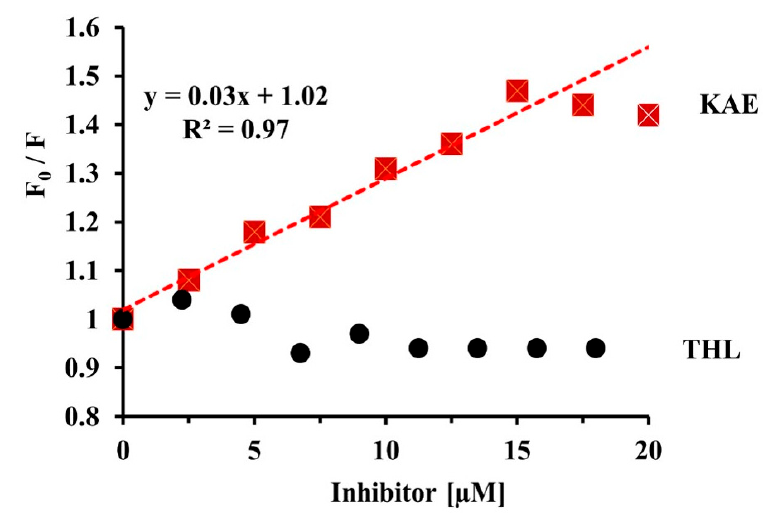
Figure 5. Stern–Volmer plots (F 0 / F) for quenhing of CpLIP2 lipase fluorescence by THL (black circle) and KAE (red square) as a function of their concentrations. THL concentrations: 0, 2.25, 4.5, 6.75, 9, 11.25, 13.5, 15.75, 18 µM. KAE concentrations: 0, 2.5, 5, 7.5, 10, 12.5, 15, 17.5 µM. CpLIP2 was used at 2.5 µM and inhibited by THL or KAE through a pre-incubation step for 30 min at 25 °C with 50 mM sodium phosphate buffer (pH 7.0), 300 mM NaCl and EtOH 0.01%. The fluorescence emission intensity was recorded at ʎ ex = 285 nm and ʎ em = 350 nm. Values represent the mean of three replicates. Correction of the inner filter was applied systematically.